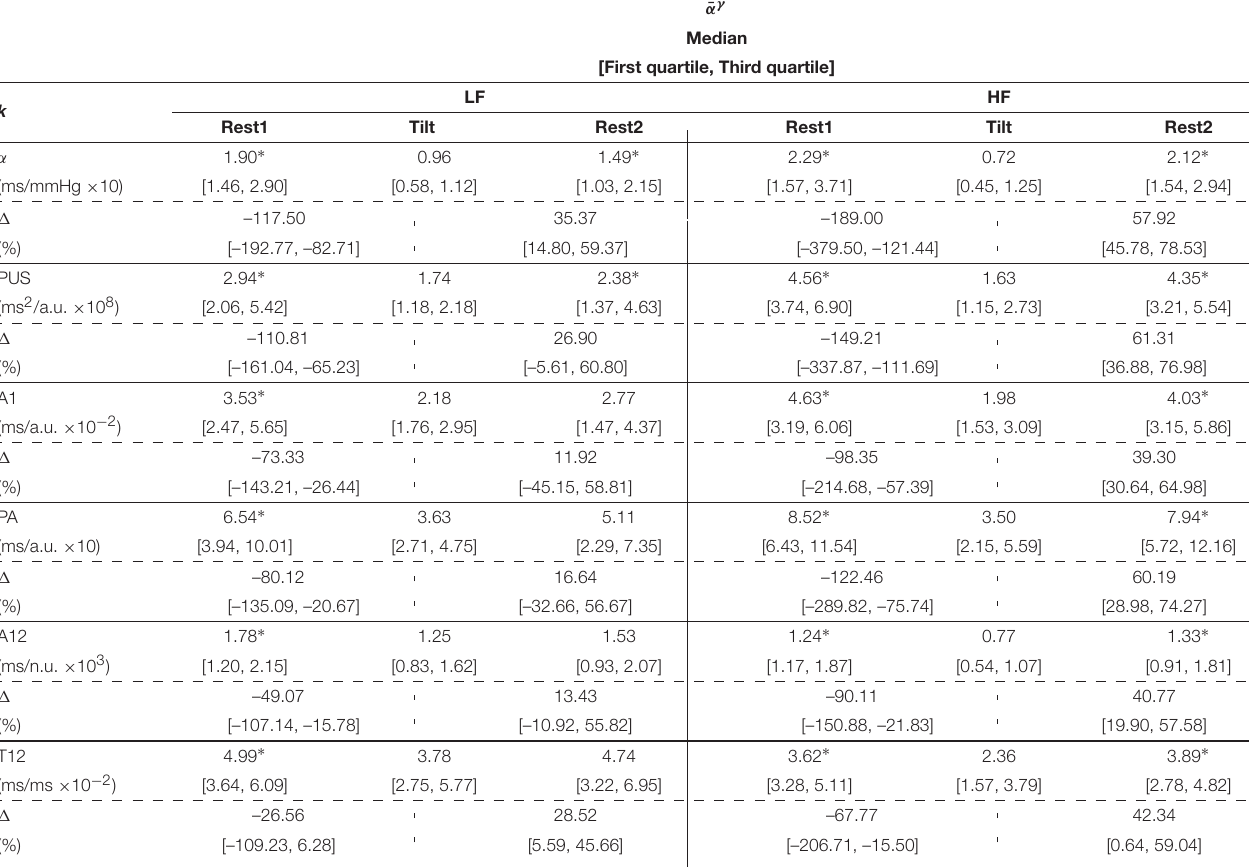
TABLE 4 | Inter-subject median and interquartile ranges of intra-subject median of ¯ α { LF γ ,HF γ } and ¯ α { LF γ ,HF γ }